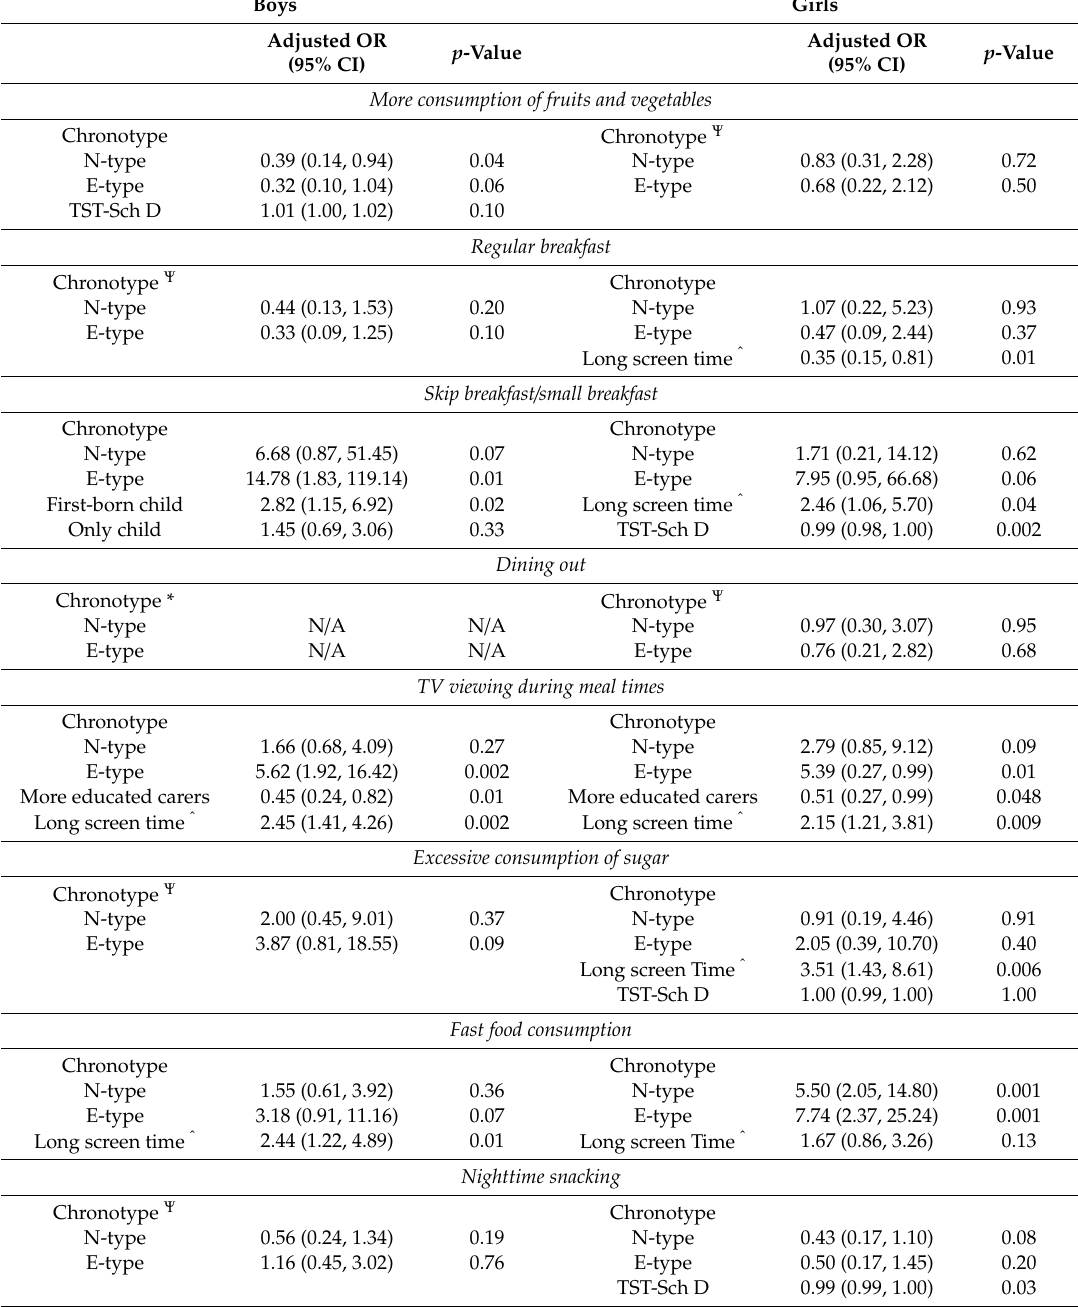
Table 3. Factors associated with specific dietary variables by multivariate logistic analysis in boys and girls #